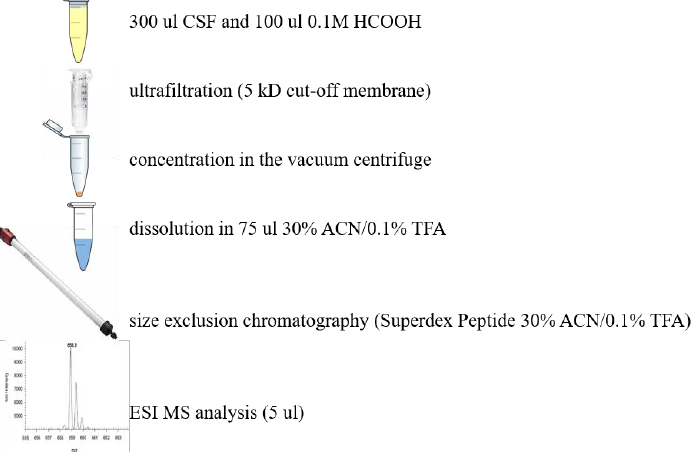
Figure 3. Isolation and identification of LVV-H-7 obtained from hCSF of patients suffering from cerebral bleeding, for direct MS analysis.